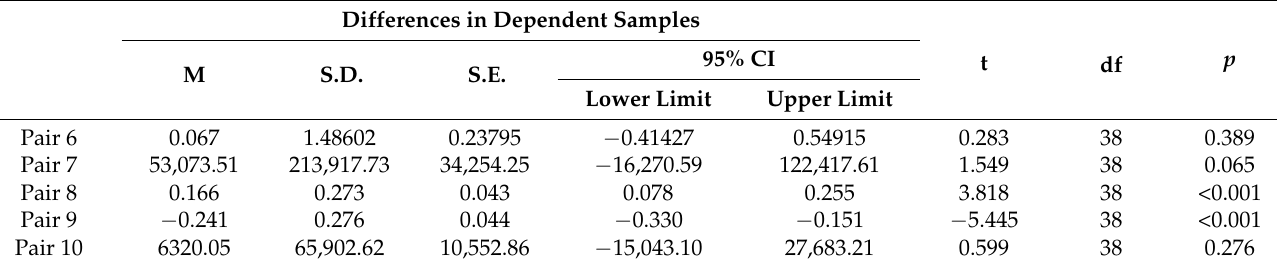
Table 7. Test for dependent samples.